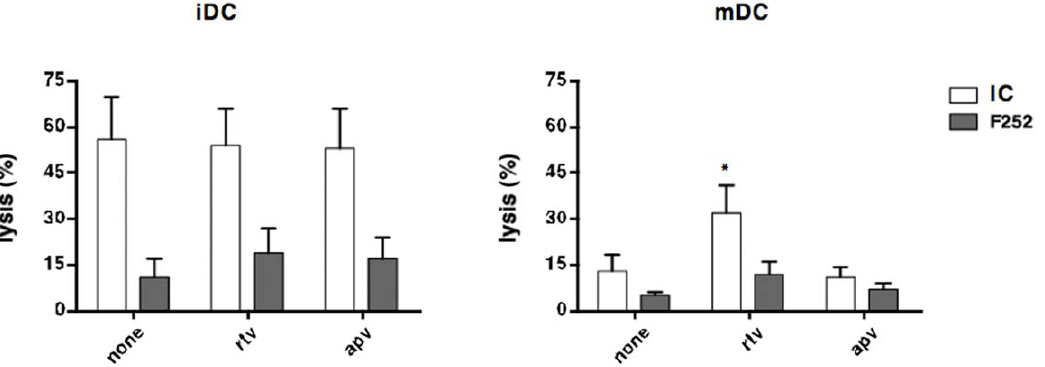
Figure 5. Mature DCs generated in the presence of ritonavir show high susceptibility to NK cell-mediated lysis. iDCs generated in the absence (none) or in the presence of PIs (rtv or apv) were exposed to LPS (100 ng/ml) for 24 hours to generate mDC. Then, aliquots of iDCs and mDCs were used as targets of NK for cytolytic activity in a Cr 51 -release assay. Open bars report the percentage of iDCs and mDC lysis by autologous NK cells (A and B, respectively). Grey bars show the percentage of lysis measured in the presence of saturating amounts of antibodies toward the activating NK receptors NKp30 or isotype control (F252 and IC, respectively). Mean and SD are calculated on five independent experiments. (* p , 0.005).